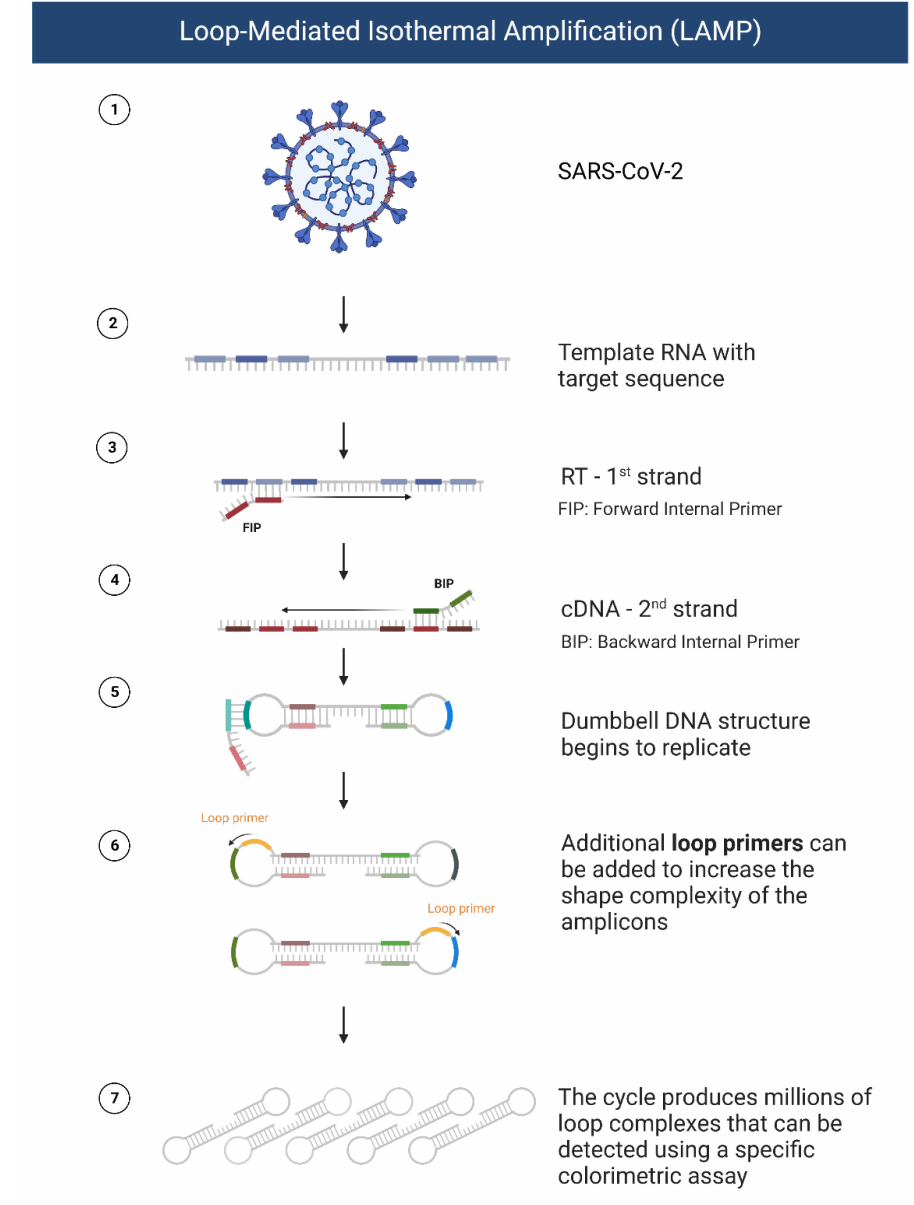
Figure 4. Schematic representation of loop-mediated isothermal amplification of SARS-CoV-2 RNA